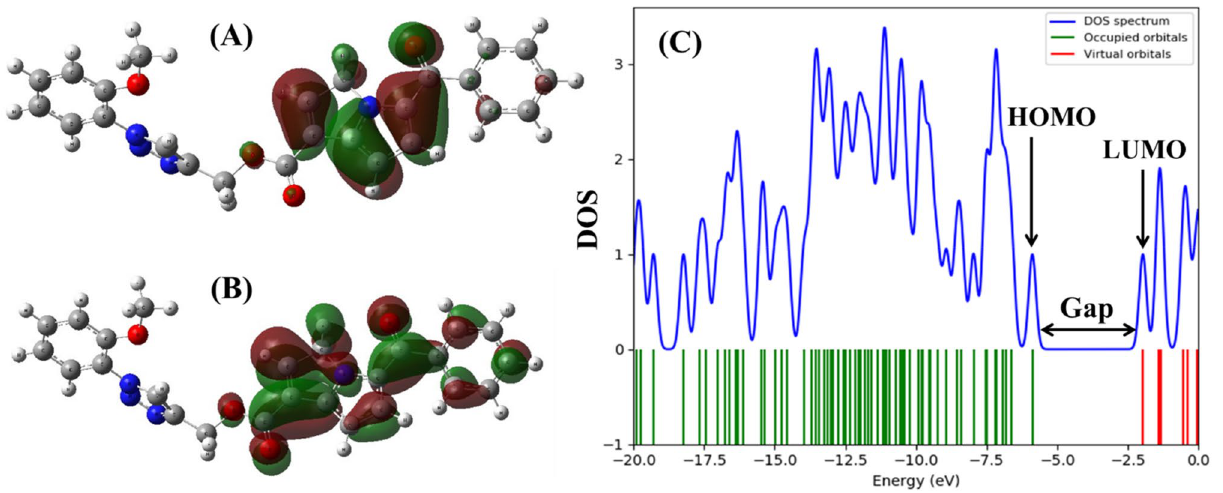
Figure 2. Molecular orbital distribution plots of HOMO and LUMO in the ground state of 15K at DFT/B3LYP level of theory in the gas phase ( A , B ). Density of state (DOS) plot ( C ) showing the HOMO–LUMO energy gap of